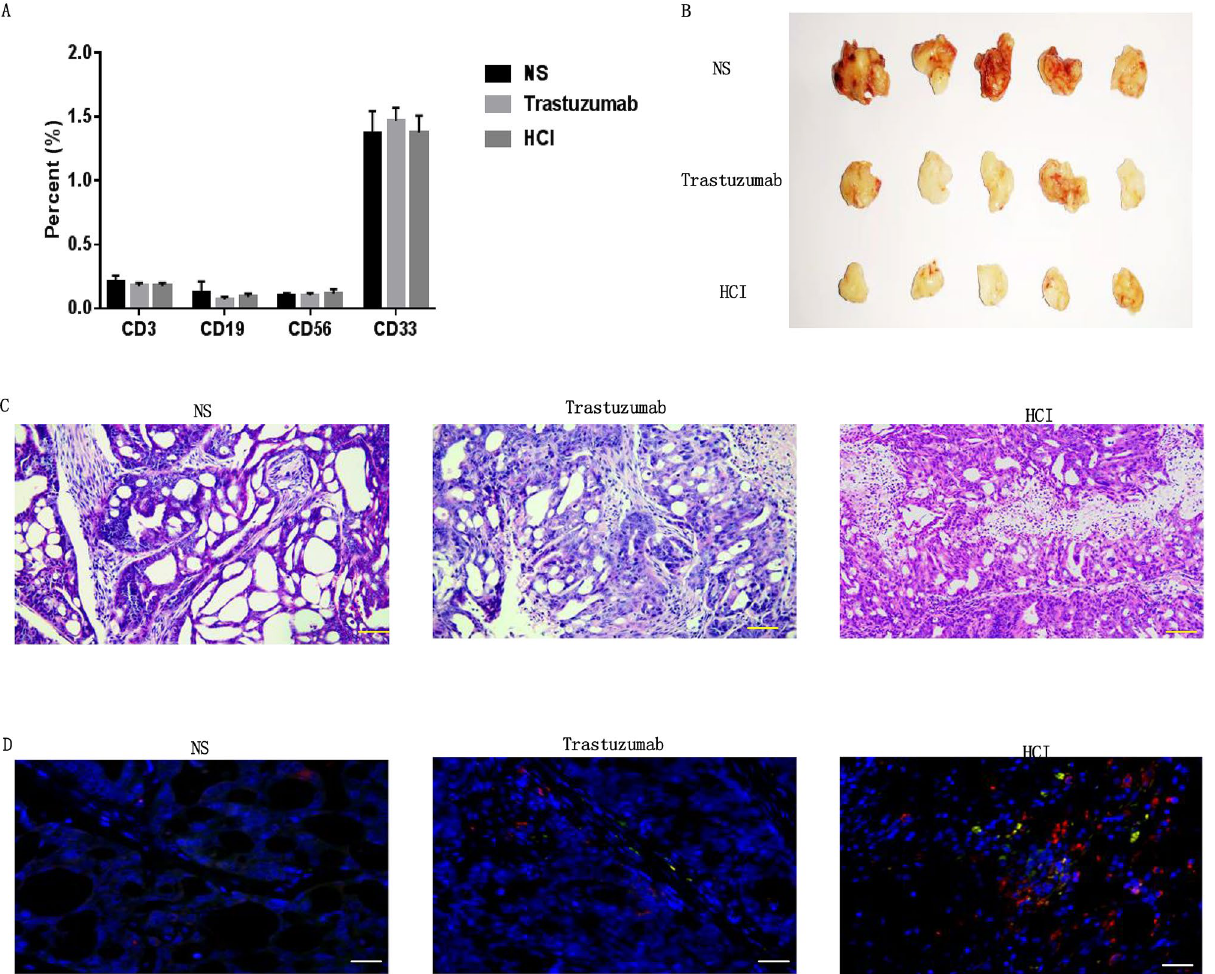
Figure 4. HCI fusion protein mediated autoimmune cell antitumor activity in vivo. ( A ) FACS analysis revealed the presence of memory associated human cells in NOD/SCID mouse peripheral blood 4 weeks after homoimmune reconstitution. ( B ) Tumor tissue images of sacrificed mice with different effector cell treatments are shown. ( C ) After sacrifice, the tumor tissues were obtained and cut into sections for H&E staining. Images of NS (left), trastuzumab (middle) and HCI fusion protein(right)-treated groups of sections are shown, scale bars = 50 μm. ( D ) Immunofluorescence images showing DC (anti-DEC205 staining, green) and T cell infiltration (anti-CD3 staining, red)in the NS(left), trastuzumab (middle) and HCI fusion protein(right)-treated groups, scale bars = 50